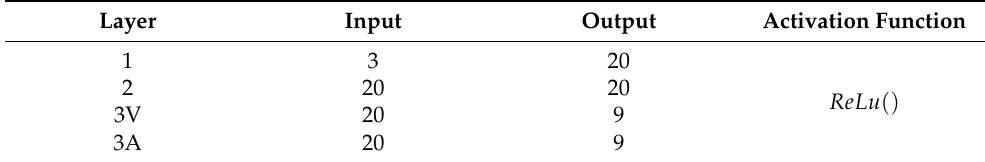
Table 2. Structure of the neural